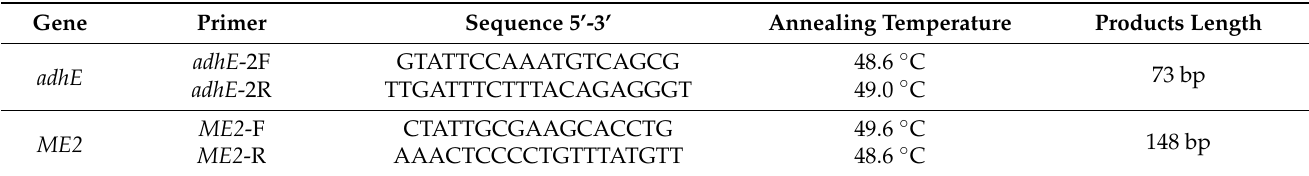
Table 2. Primers for qPCR of gene ME2 and adhE